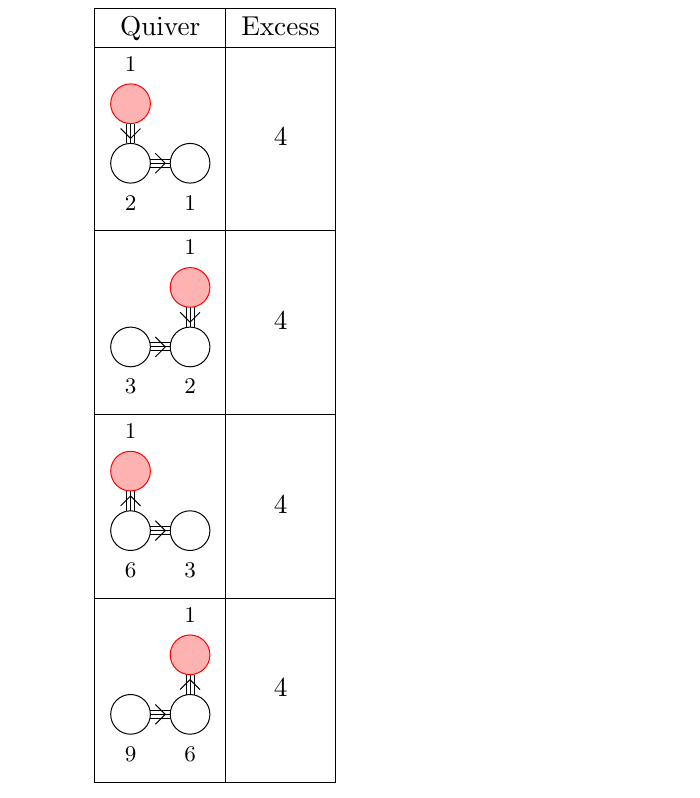
Table 35 . Exotic minimally unbalanced quivers with G = G 2 and an extra triple laced edge.